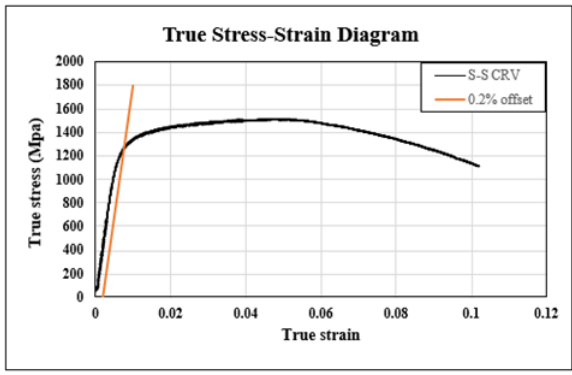
Figure 11. True stress–strain graph of SKD61. Table 4. Tensile test results of SKD61.